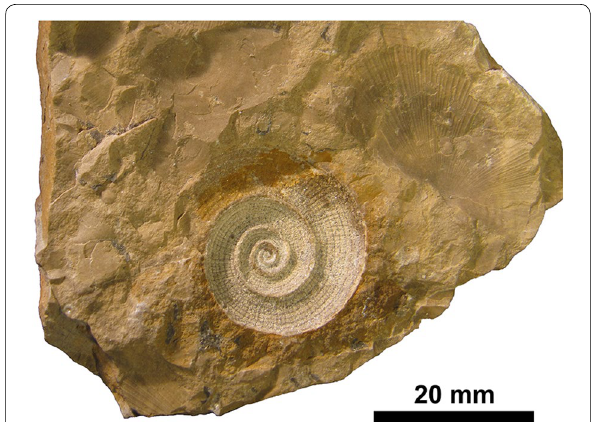
Fig. 2 Frederikella cf. cancellata (Zardini 1978). The original specimen PIMUZ 29952 with external mold (apical side) in association with Daonella cf. angulata Rieber 1968. Point 902/Mirigioli (Monte San Giorgio), Lower Besano Formation (bed